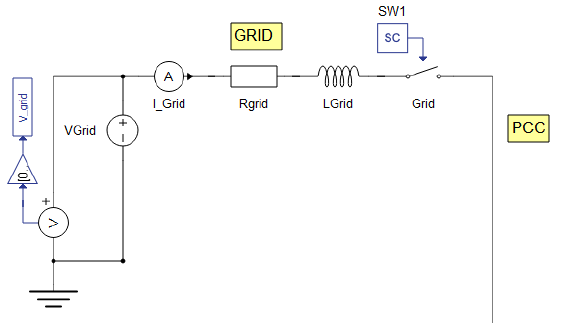
Figure 16. Main grid experiment block.